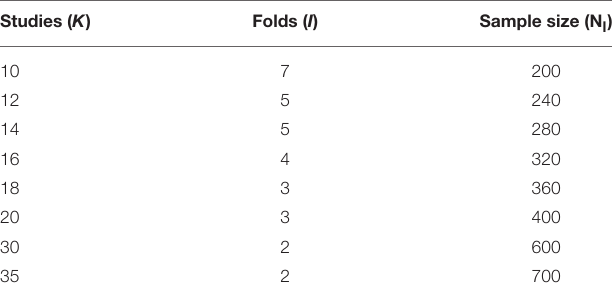
TABLE 1 | Overview of the different designs